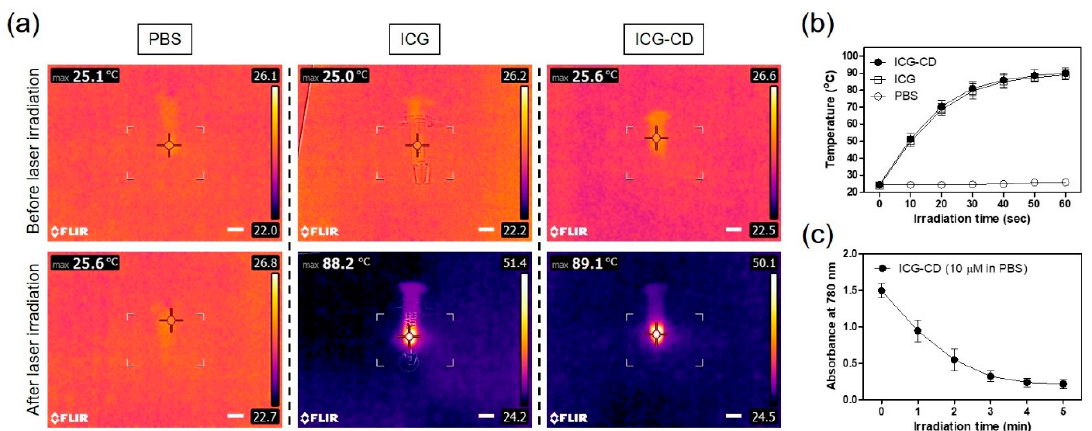
Figure 3. ( a ) In vitro photothermal images of the free ICG and ICG-CD complex diluted in PBS (10 nmol based on the absorbance of ICG; 100 µ M is equivalent to a single dose of 0.3 mg / kg of ICG) and PBS alone (100 µ L) exposed to 808 nm laser (1.1 W / cm 2 ) for 1 min. The maximum temperature was automatically recorded using an infrared thermal camera as a function of irradiation time. Scale bars = 1 cm. ( b ) Temperature changes in the solutions in each sample were monitored during 1 min of laser irradiation. ( c ) Changes in absorbance of the ICG-CD complex solution (10 µ M) were measured at 780 nm during 5 min of laser irradiation. Data are expressed as the mean ± S.D. of three independent experiments.